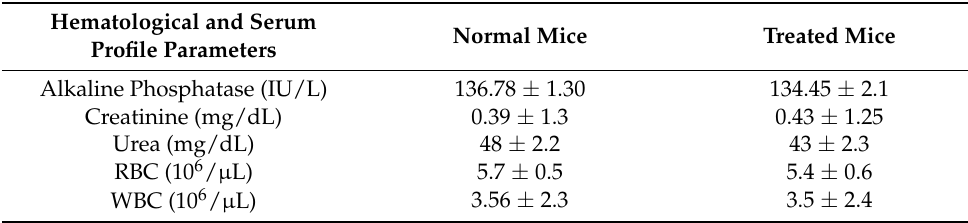
Table 2. Showing hematological and serum profiles of the normal mice and normal non-tumor bearing mice treated with complex C4